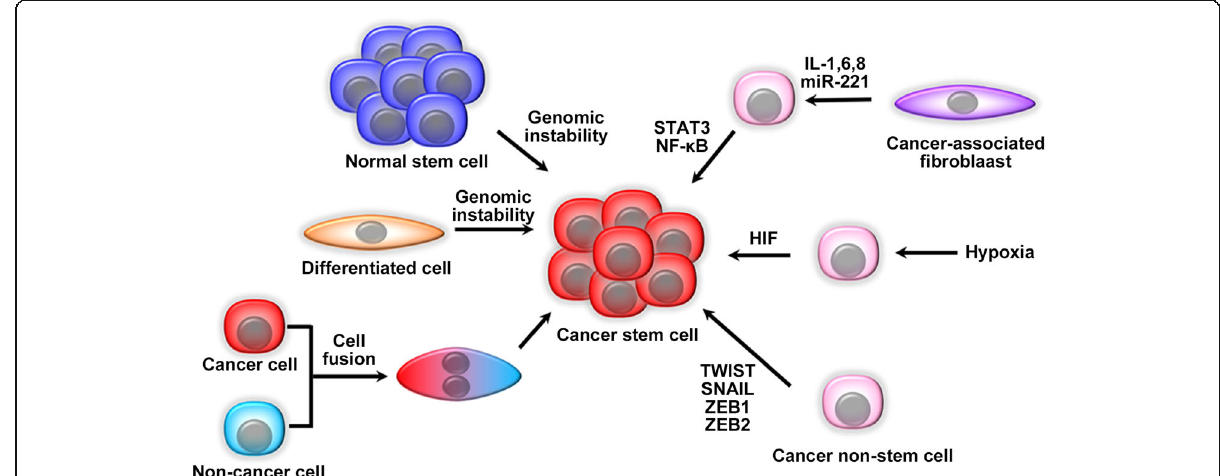
Fig. 2 The origin of CSCs. Genetic mutations generate CSCs from tissue resident stem cells or differentiated cells. CSCs can be generated also by cell fusion between normal and cancer cells. Hypoxia induces cancer non-stem cells to display CSC phenotypes by activating hypoxia inducible factor (HIF) or signal transducer and activator of transcription (STAT)3 pathway. Moreover, the interaction between cancer and stromal cells produces various cytokines to activate STAT3/nuclear factor (NF)- κ B pathways in both cancer and stromal cells, thereby driving CSC generation from non-CSC populations. Furthermore, CSCs are generated from non-CSC population by the action of a number of EMT-inducing transcription factors such as TWIST, SNAIL, ZEB1, and